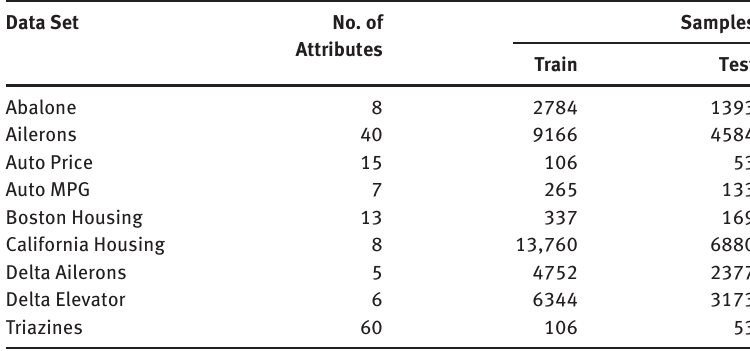
Table 2. Information about the Selected Data